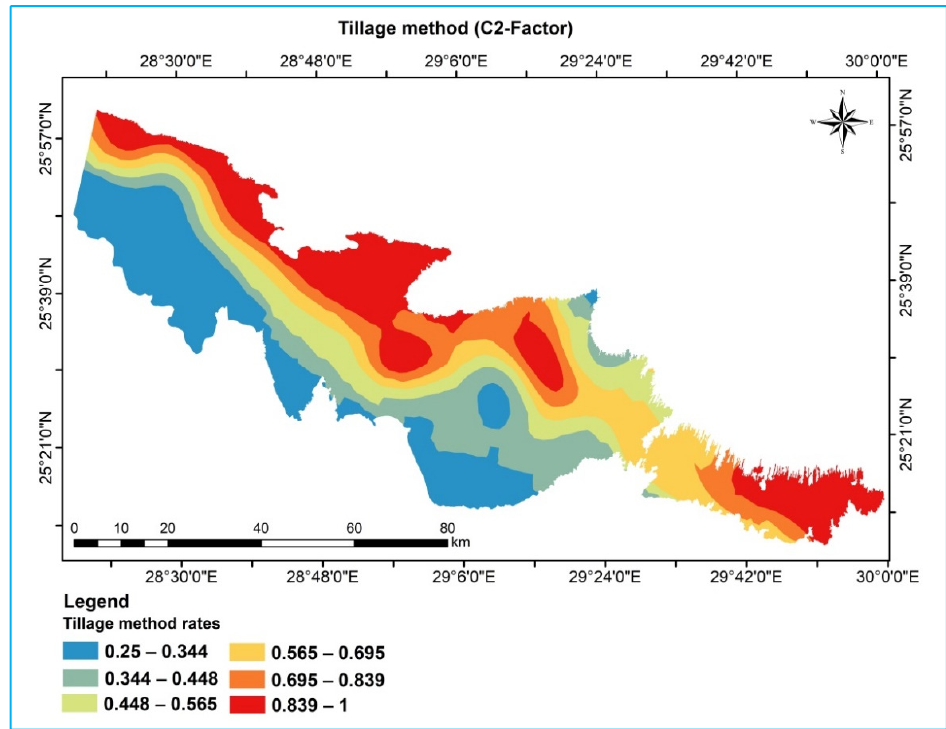
Figure 10. Spatial distribution map of the tillage method factor (C2-Factor).